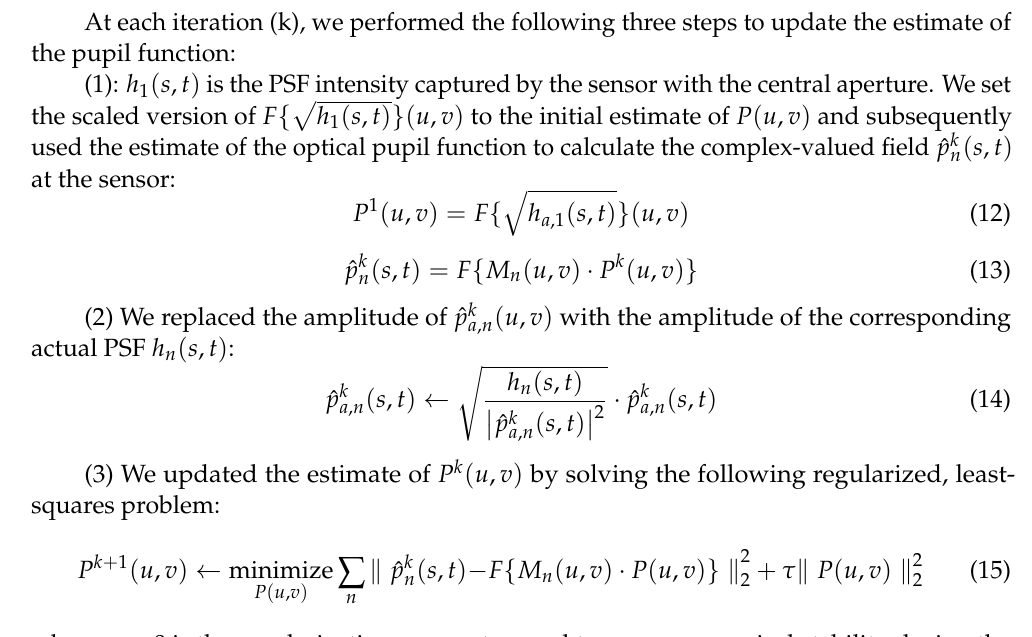
Figure 4. The algorithm flow chart of the pupil function reconstruction process.